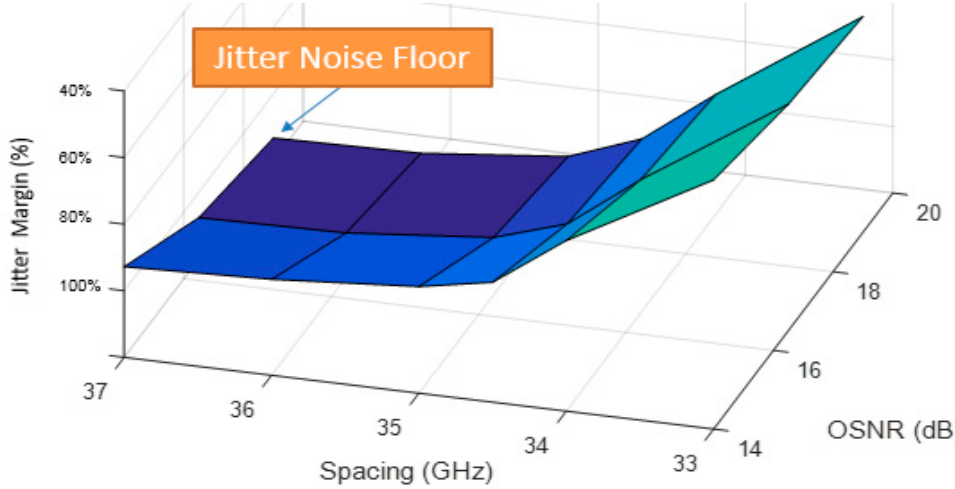
Figure 9. Jitter margin as function of channel spacing and link OSNR.